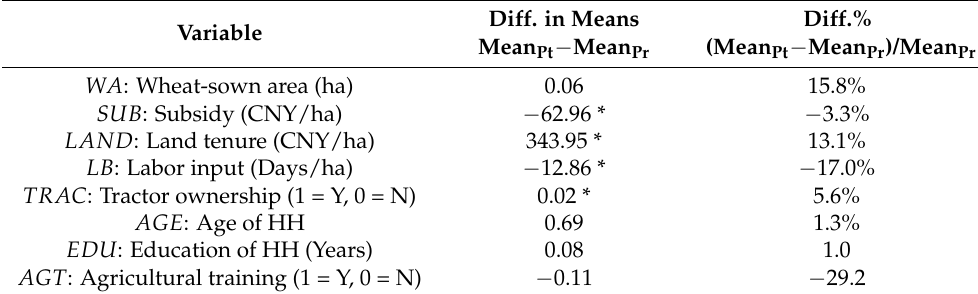
Table 3. Differences of variables between the pre- and post-treatment groups. Diff. in Variable